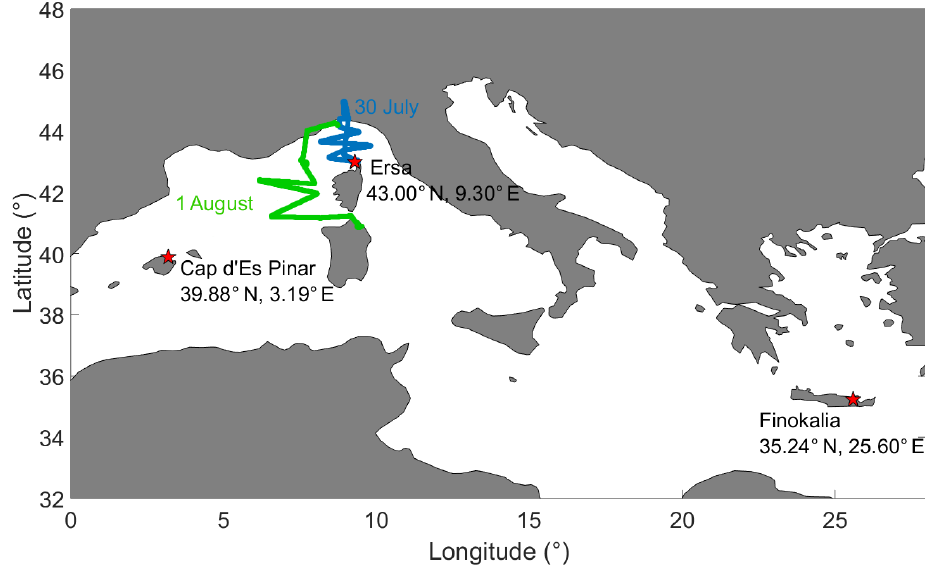
Figure 1. Locations of the stations: Ersa (Corsica), Finokalia (Crete), and Cap d’Es Pinar (Mallorca). Aircraft flight paths from 30 July and 1 August are also